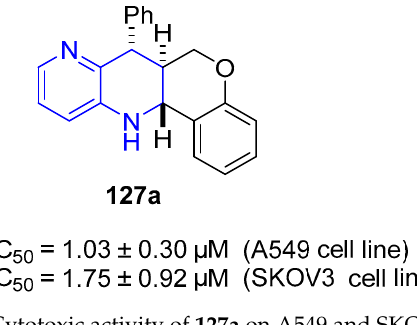
Figure 10. Cytotoxic activity of 127a on A549 and SKOV3 cell lines.